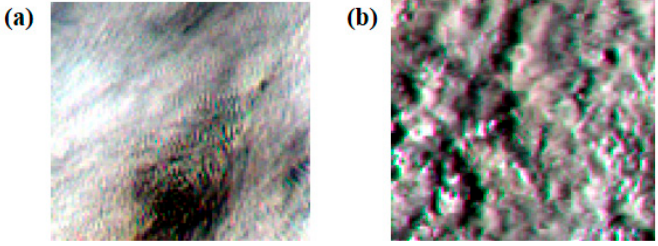
Figure 2. Representative images for sea fog and clouds: ( a ) sea fog has a fine texture; ( b ) cloud has a coarse surface texture. These two images have RGB composition (R-6, G-4, B-2) to show texture differences, while Figure 1 shows color difference.